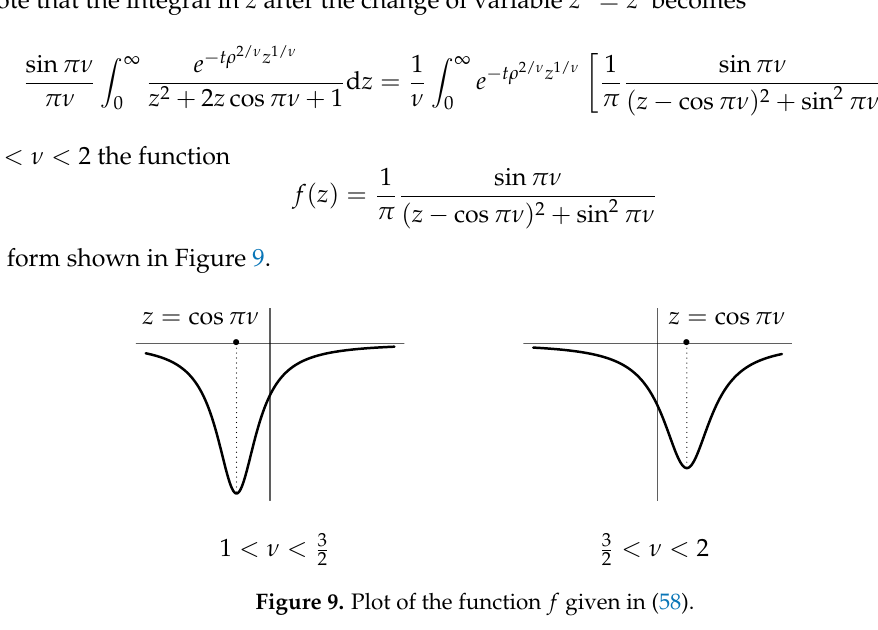
Figure 9. Plot of the function f given in